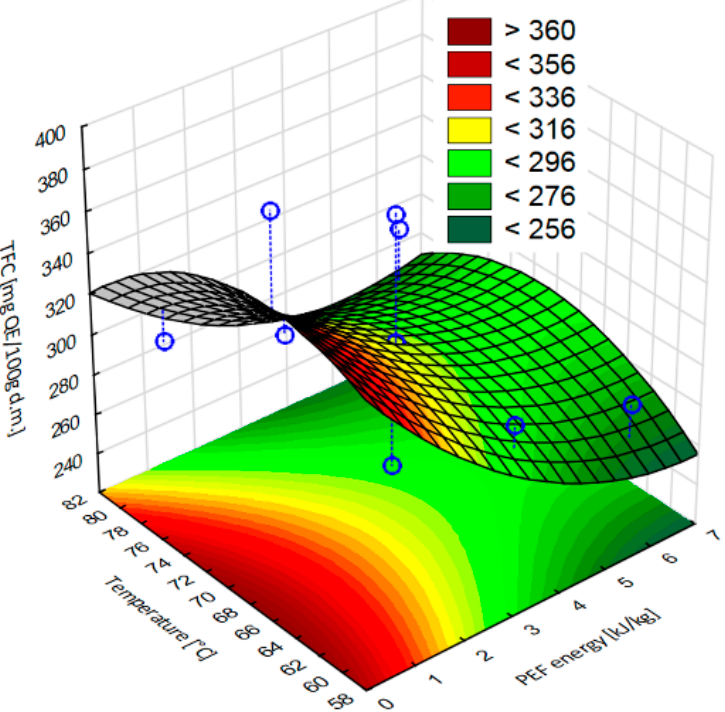
Figure 7. Response surface results of the total flavonoid content, depending on the pulsed electric field intensity and the temperature, obtained in the case of apple tissue subjected to different PEF pretreatment intensities (1, 3.5, and 6 kJ/kg) and hot air drying at different temperatures (60, 70, and 80 °C). Experimental values are marked with points.